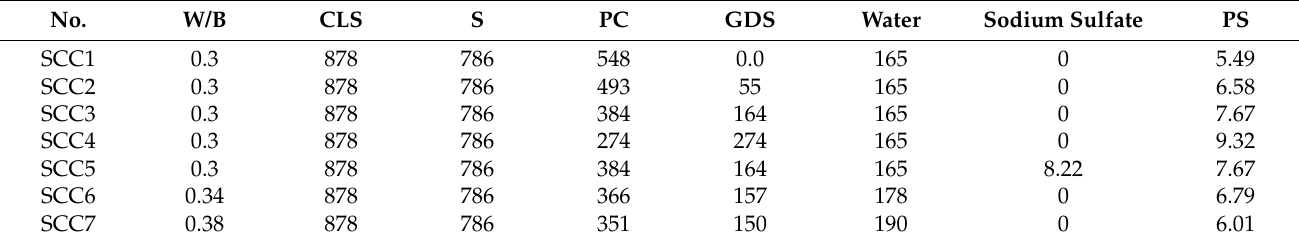
Table 2. The compositions’ amount of the SCCs (kg/m 3 ).